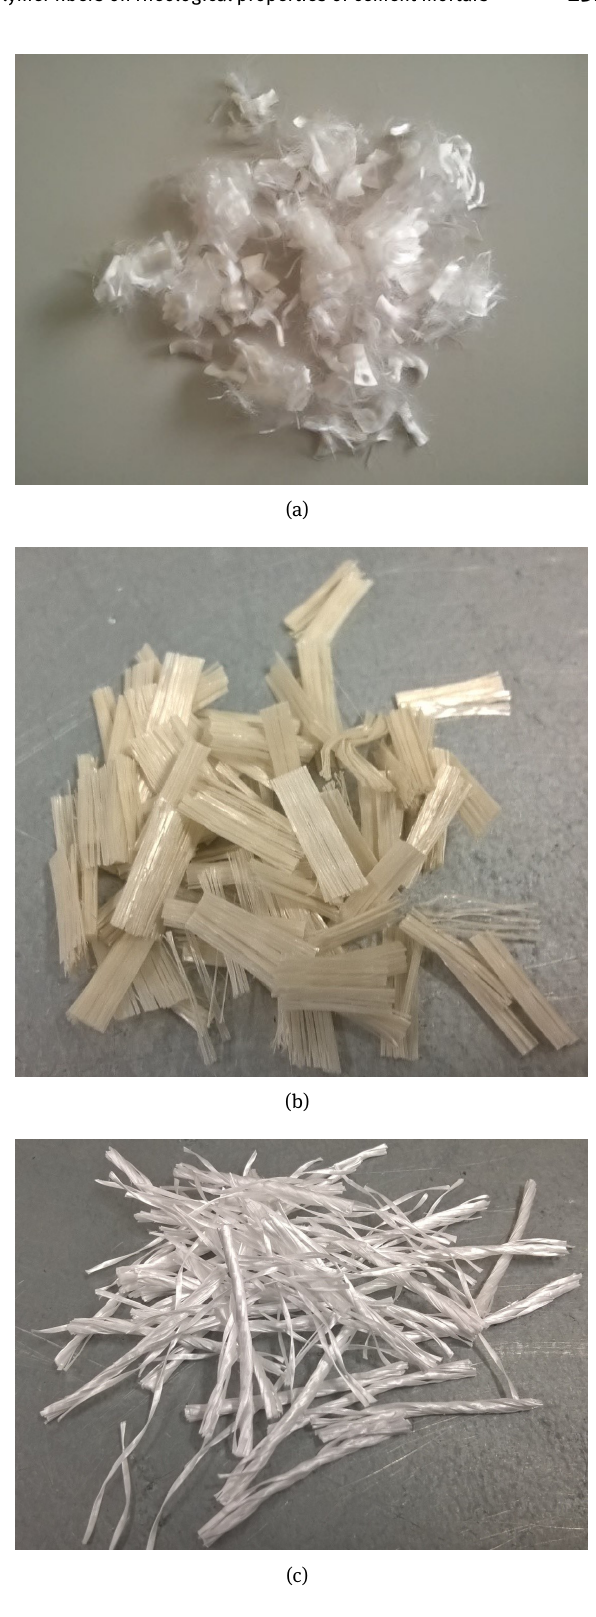
Figure 4: Fibers a) Fib1 - fibrillated isotactic polypropylene ; b) Fib2 - fibrillated refined polypropylen; c) Fib3 - copolymer profiled